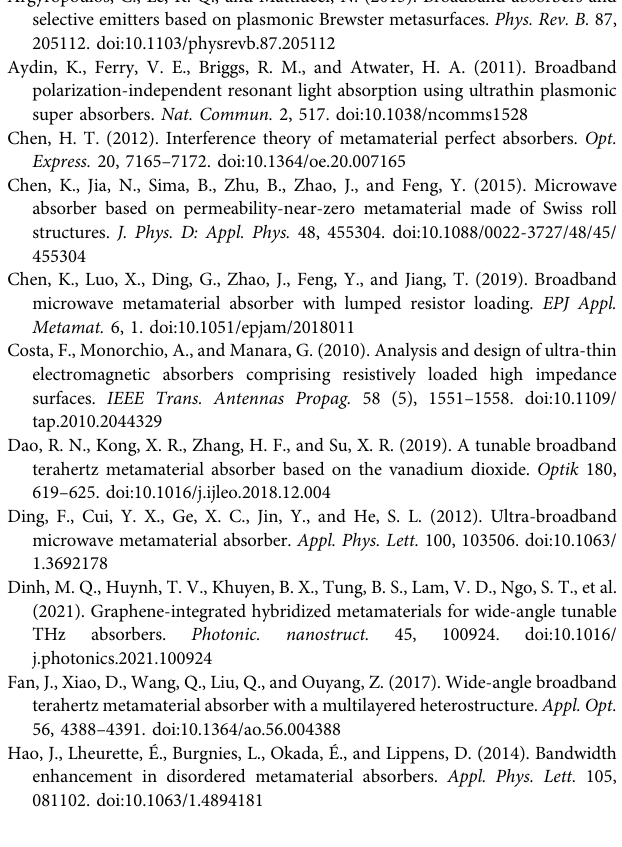
Frontiers in Materials |